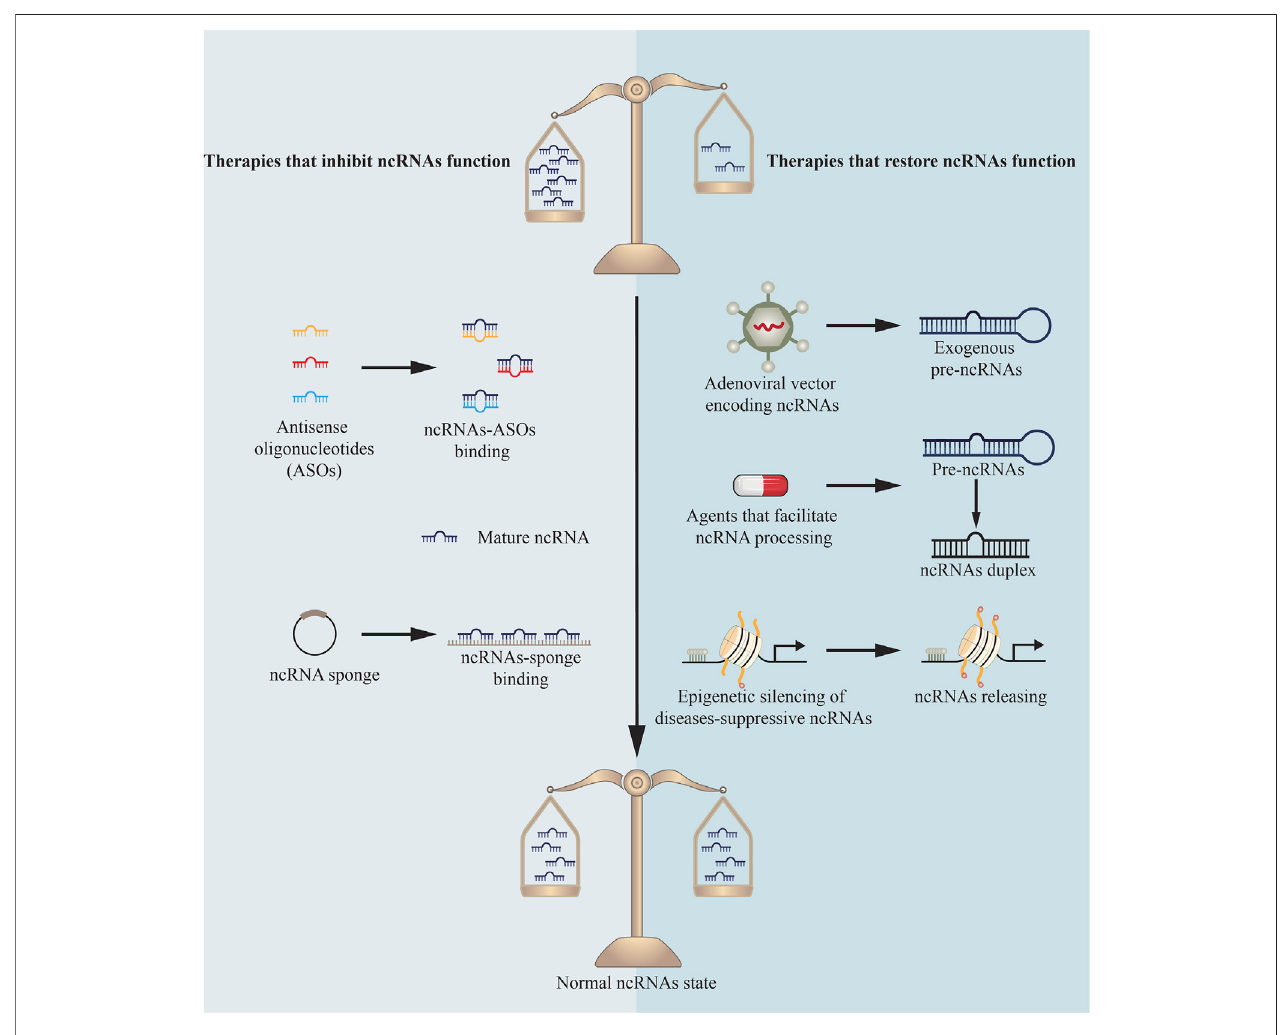
FIGURE 3 | Therapies targeting